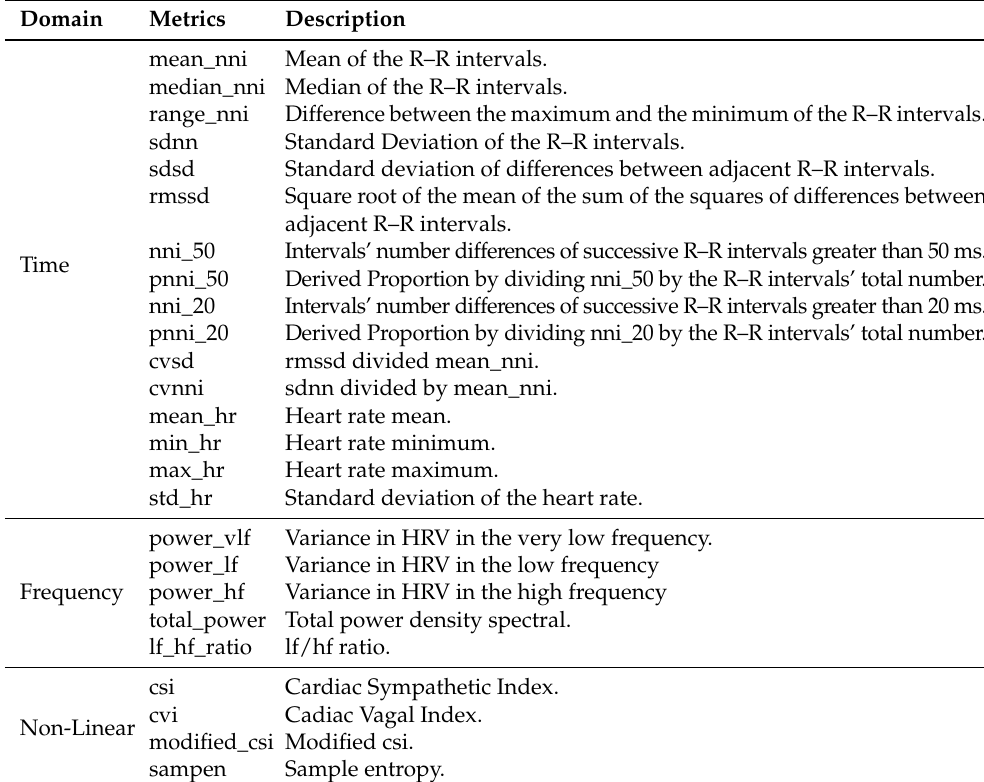
Table 4. Heart Rate Variability Time Domain